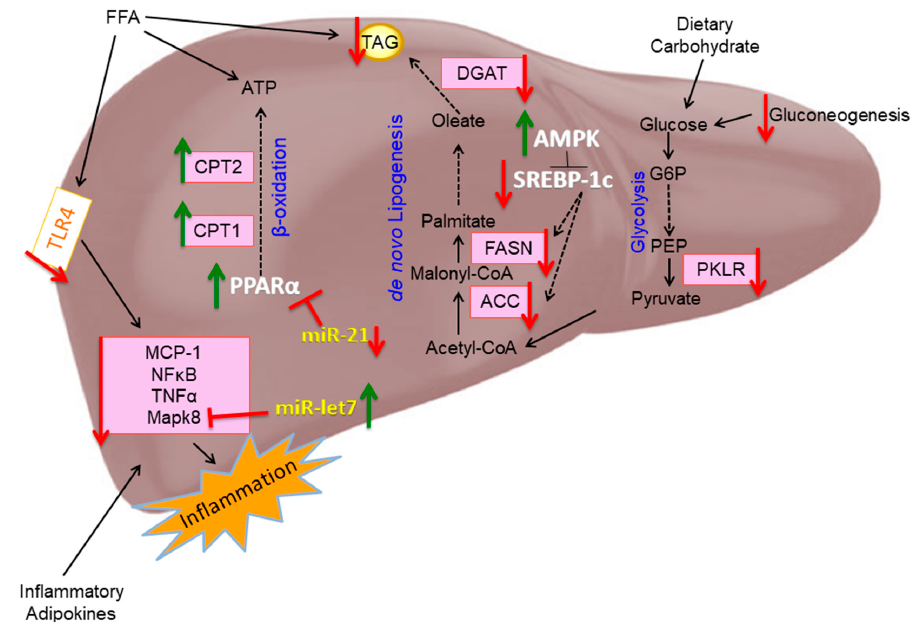
Figure 10. Proposed model of mechanistic activity of eicosapentaenoic acid (EPA) in reducing hepatic triglyceride (TAG) accumulation. EPA reduces glycolysis by reducing pyruvate kinase L/R (PKLR) and gluconeogenesis and thus the amount of glucose available for de novo lipogenesis. Further, TAG synthesis is reduced with EPA, through activation of AMP-activated protein kinase (AMPK), resulting inhibition of sterol regulatory element-binding protein-1c (SREBP-1c) and reduction of enzymes, fatty acid synthase (FASN), acetyl-CoA carboxylase (ACC), and diglyceride acetyltransferase (DGAT2). Utilization of free fatty acids (FFA) for adenosine triphosphate (ATP) generation is upregulated with EPA through induced expression of peroxisome proliferator-activated receptor-alpha (PPAR α ) and carnitine palmitoyltransferase (CPT)-1a and CPT2. Additionally, EPA reduces hepatic